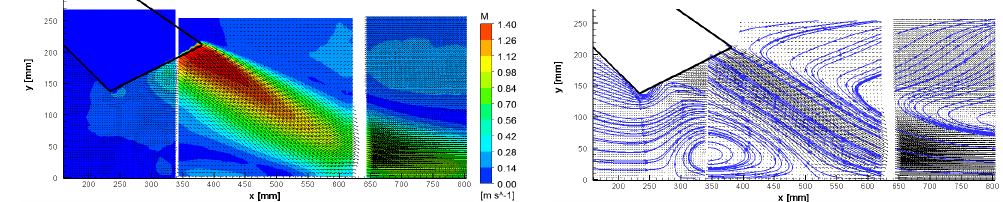
Figure 10. PIV measurements, the magnitude of time-averaged 2D velocity (left panel) and vector lines in vertical plane ( z = 0mm )